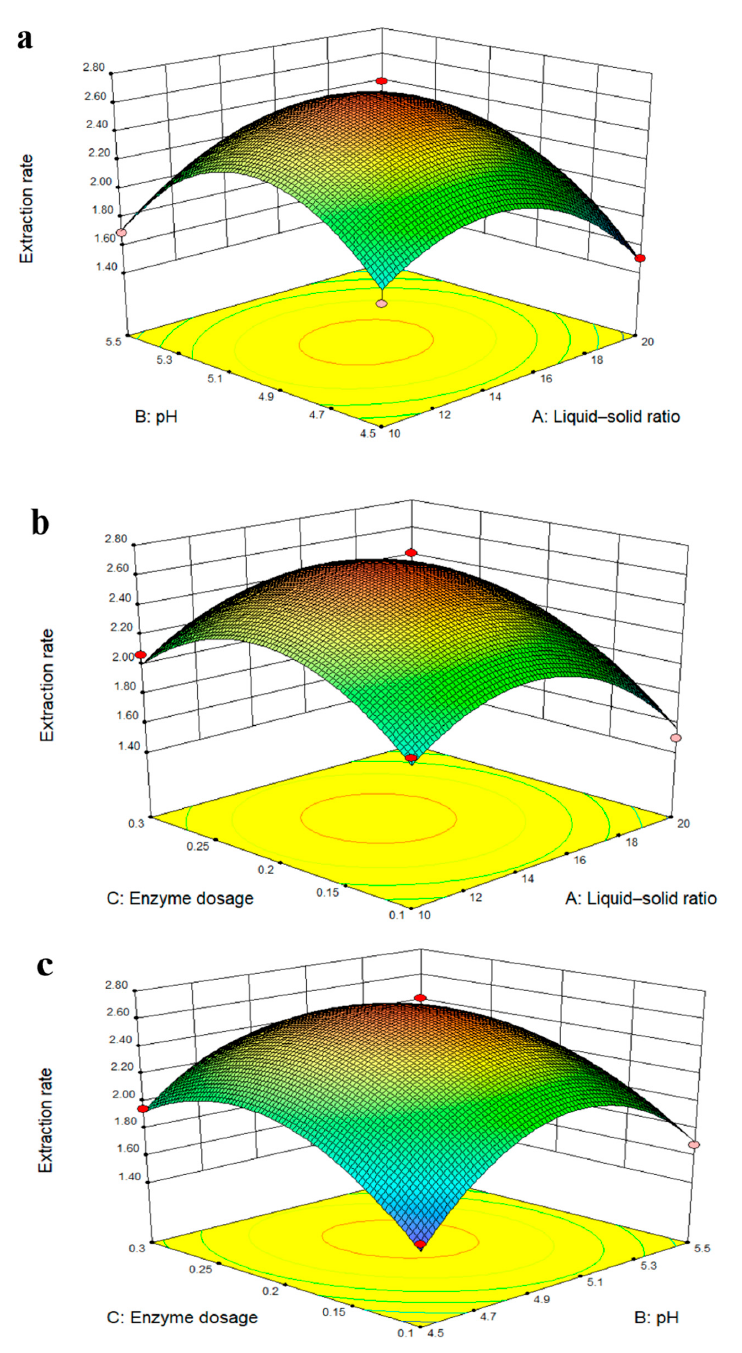
Figure 3. Response surface analysis diagram: ( a ) the reciprocal response of the liquid–solid ratio and pH, ( b ) the reciprocal response of the pH and enzyme dosage, and ( c ) the reciprocal response of the liquid–solid ratio and enzyme dosage.